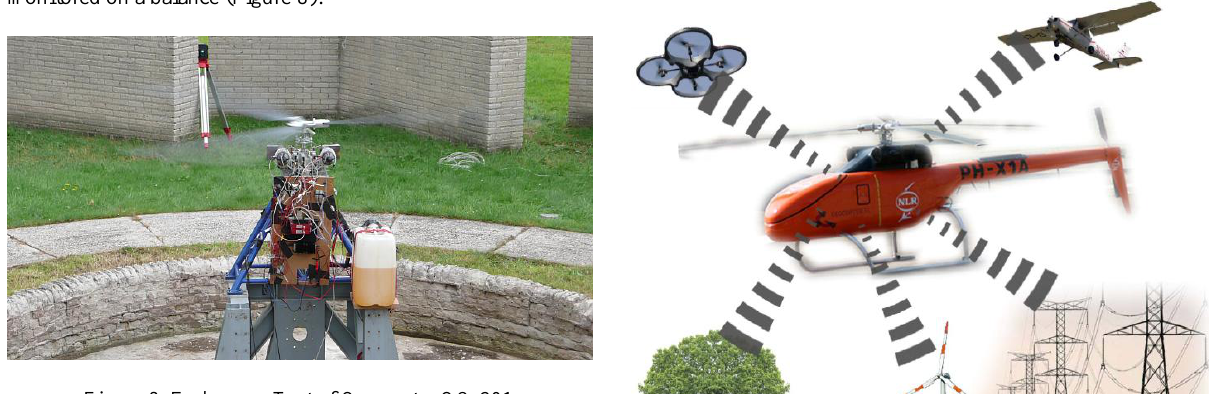
Figure 8. Endurance Test of Geocopter GC-201